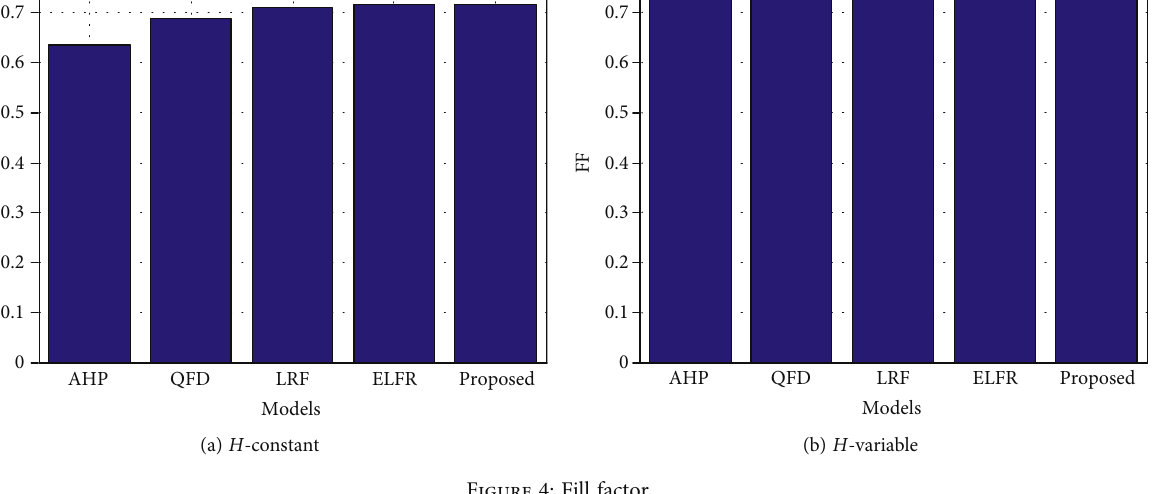
Figure 4: Fill factor.